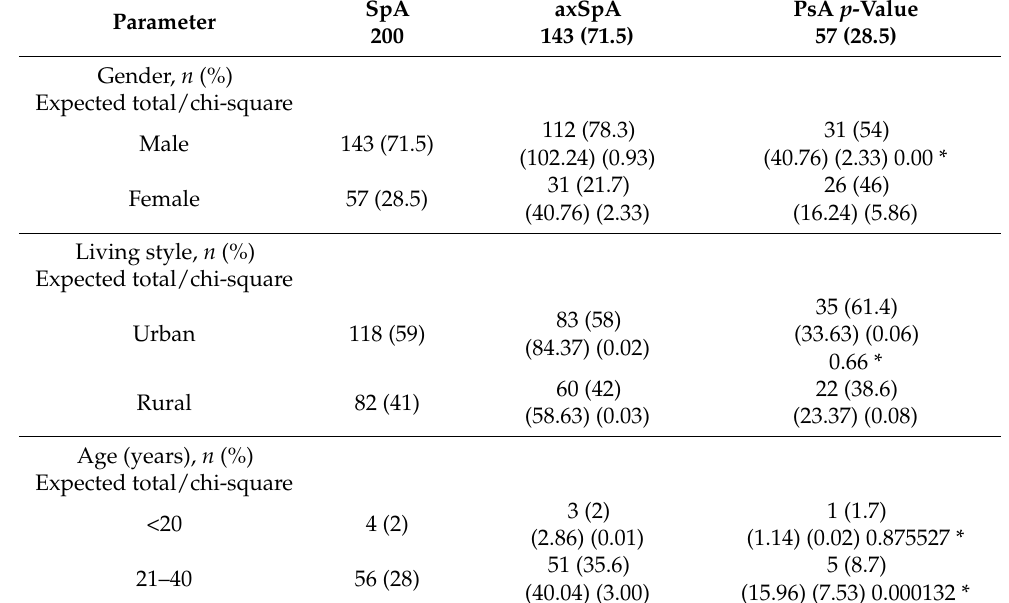
Table 2. Demographics, disease- and treatment-related parameters in study